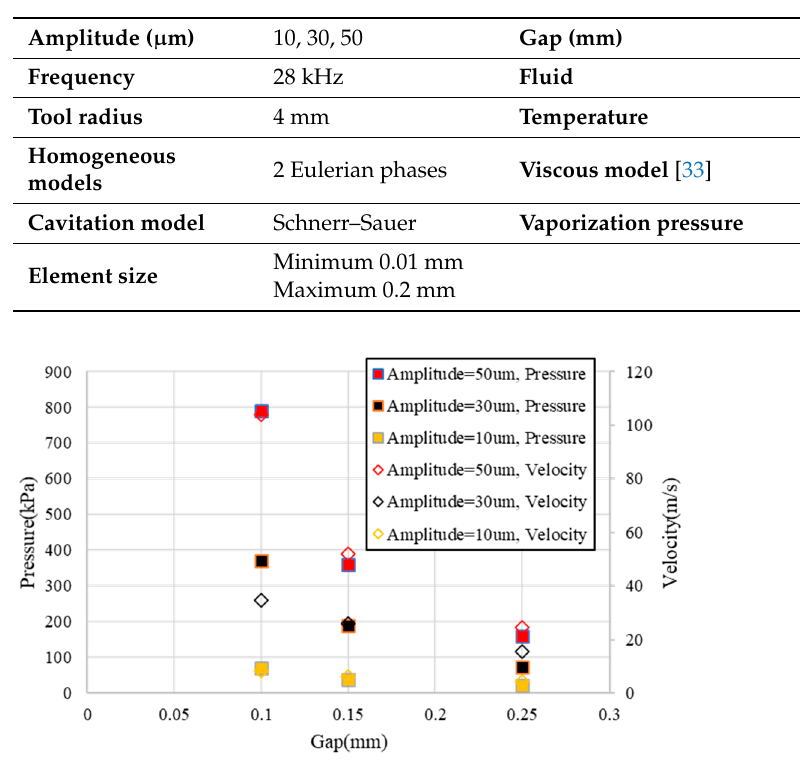
Table 1. Simulation parameters.